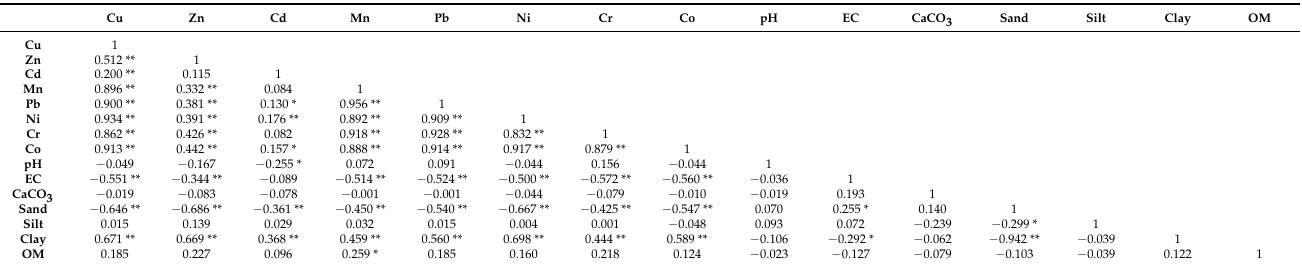
Table 6. Correlation coefficients between HMs and soil physicochemical parameters.